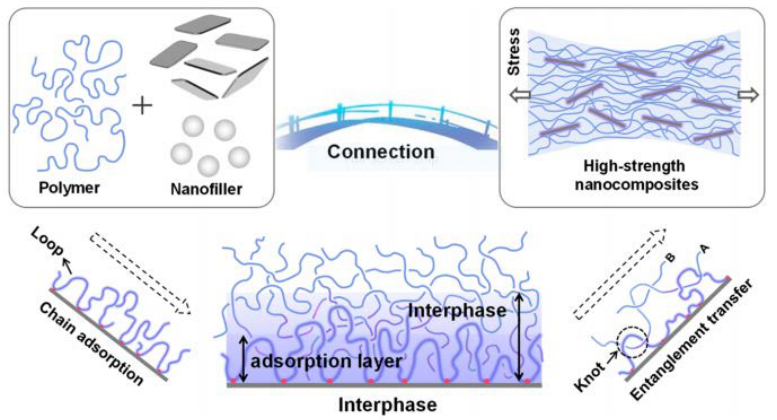
Figure 3. Formation and transfer mechanism of the interfacial phase in polymer nano composites from [24] under creative common license.